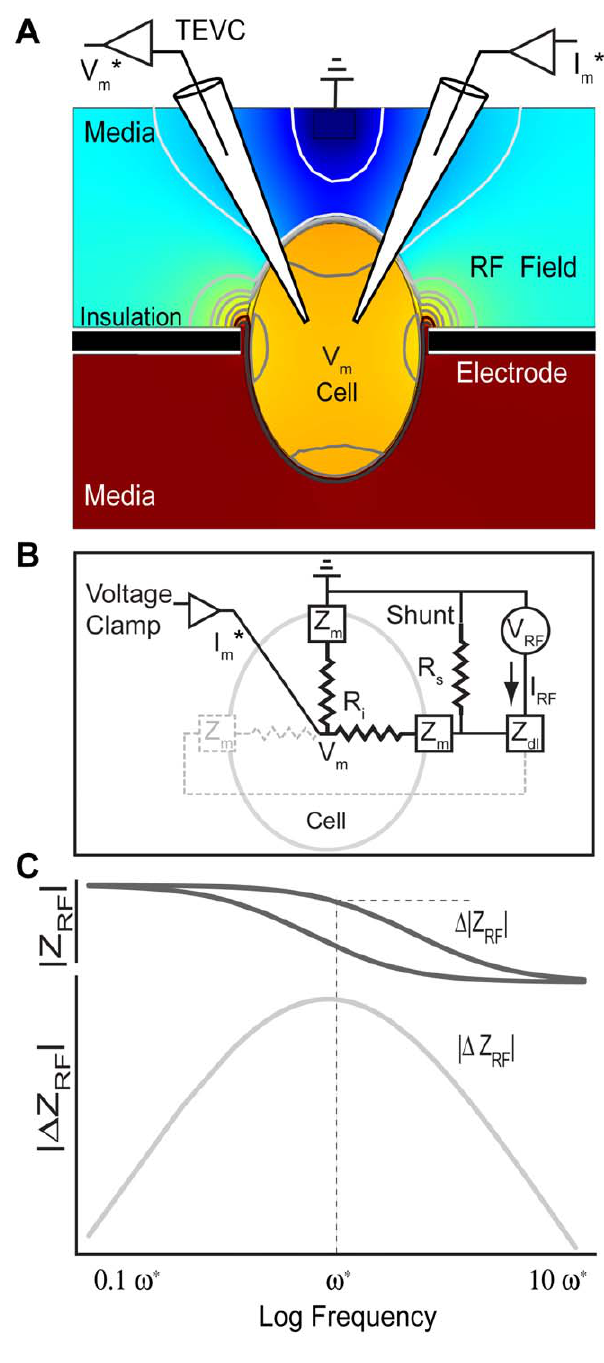
Figure 1. Set-up and circuit model. A) Changes in RF membrane impedance (| D Z RF |) during TEVC were measured by passing RF current from an electrode surrounding the meridian of the cell (black) to a ground electrode (media, above the cell). Contour lines and colors of the saggital cross-section of a cell in the recording chamber, shown here, illustrate the general spatial distribution of the RF electric potential expected based on the Maxwell equations for a passive cell under axisymmetric conditions ( p /4 phase shown). B) A circuit model of the chamber including the shunt resistance (R s ,), membrane impedance (Z m ), intracellular resistance (R i ), and electrode double layer (Z dl ). C) Using the circuit model, the frequency- dependent RF impedance would change ( D |Z RF |) with an increase or decrease in membrane capacitance — a change that would be most easily detectable at frequency v * where the maxima of the | D Z RF | occurs. The present study reports changes in RF impedance | D Z RF | evoked by TEVC step changes in membrane potential.